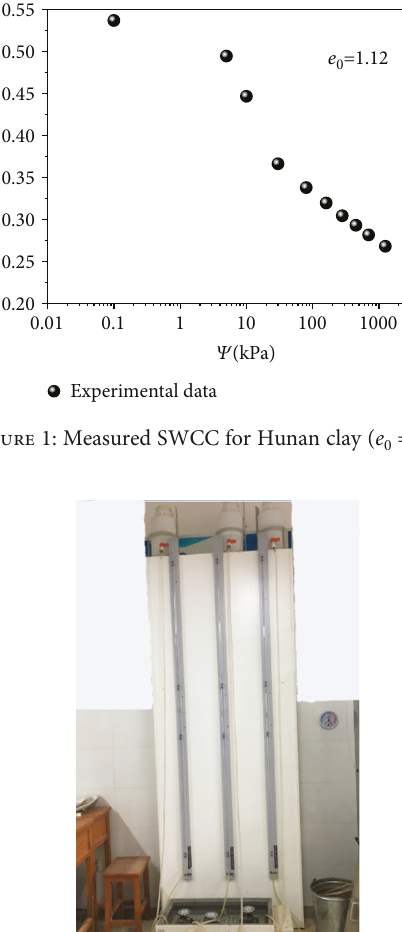
Figure 2: Saturated permeability